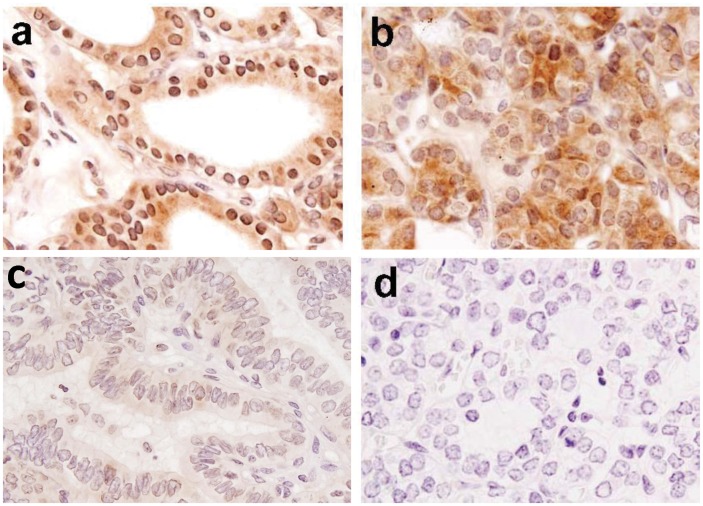
Immunohistochemical analysis of biotinidase in thyroid tissues.Paraffin embedded sections of benign thyroid nodules and malignant tumors were stained using anti-biotinidase polyclonal antibody as described in the Methods section: a) Benign tissue section showing nuclear and overall biotinidase immunostaining; b) Papillary non-aggressive thyroid cancer section illustrating reduction in nuclear staining and increase of cytoplasmic biotinidase immunostaining in the tumor cells; c) Papillary aggressive thyroid cancer section showing reduced overall (nuclear and cytoplasmic) biotinidase immunostaining; d) Thyroid cancer section used as a negative control, showing no immunoreactivity in cells (a–d, original magnification x 400).